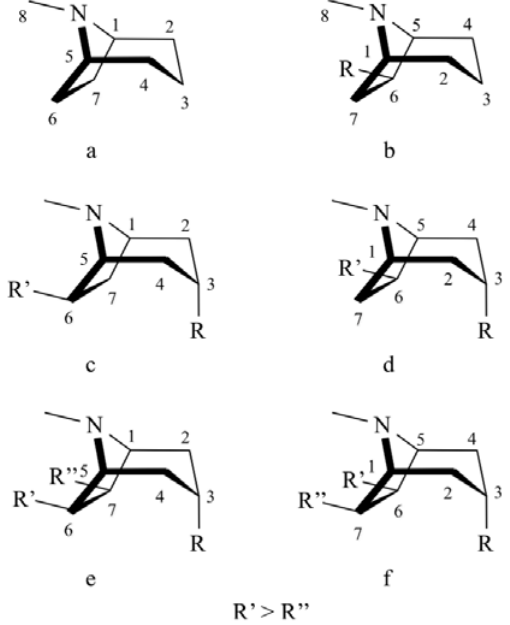
Figure 1. Tropane nucleus numbering, a, c and e: clockwise; b, d and f: